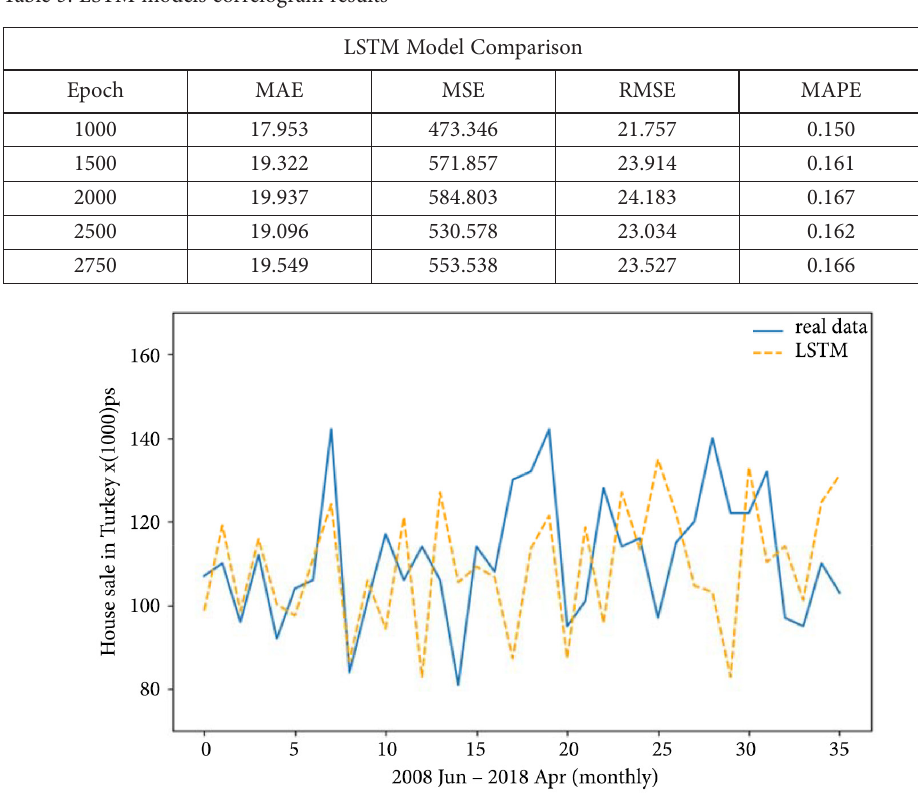
Table 3. LSTM models correlogram results